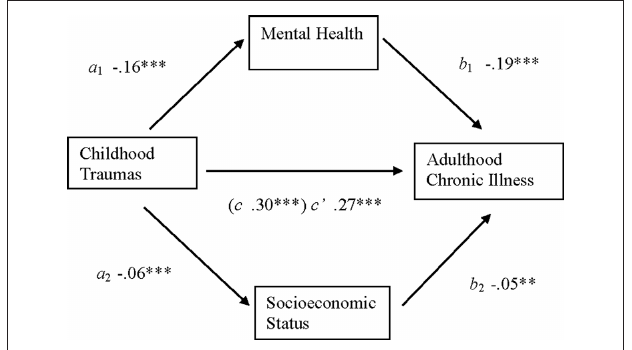
Figure 1 | Association between childhood trauma and chronic illness in adulthood mediated by self-rated mental health and socioeconomic status. The value in parentheses is the unstandardized regression coefficient for the association between childhood traumas and adulthood chronic illness before the addition of self-rated mental health and socioeconomic status to the model. n = 9,301; ** p < 0.01 ***, p < 0.001.